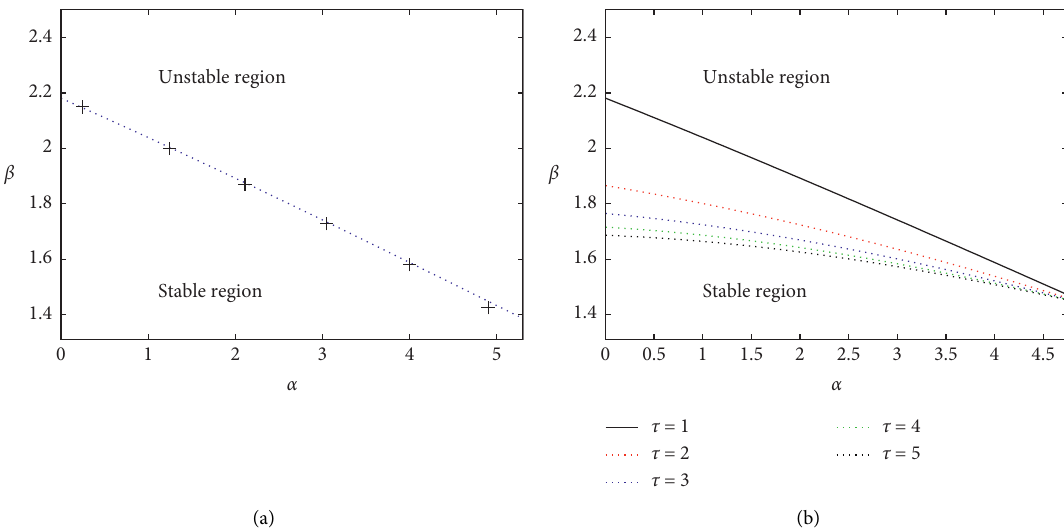
Figure 2: An exploration of the Hopf bifurcation maps in the α − β diagrams: (a) analytical and numerical simulation results and (b) analytical results for the two-term solution for five different values of τ .